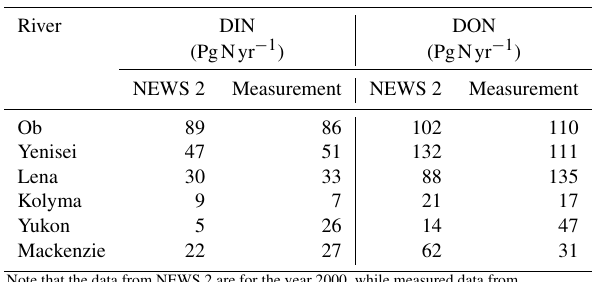
Table C1. Comparison between NEWS 2 dataset (Mayorga et al., 2010) and measurement-based (provided by PARTNERS Project; Holmes et al., 2012) riverine dissolved inorganic nitrogen (DIN) and dissolved organic nitrogen (DON) in the six largest Arctic rivers around the year